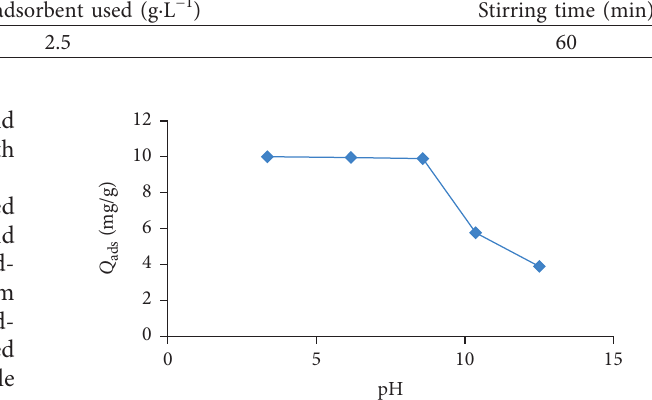
Figure 13: Effect of pH treatment on the adsorption of phenol on Sale